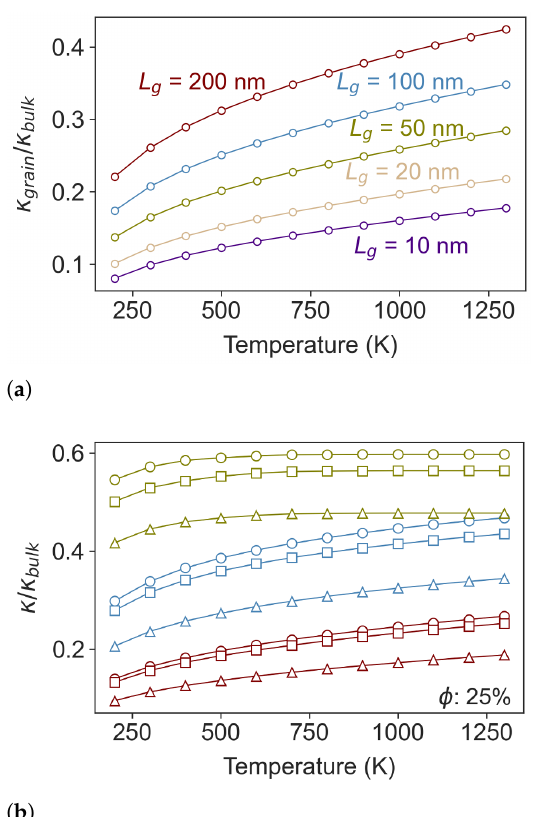
Figure 2. ( a ) Thermal conductivity of polycrystalline Si 0.8 Ge 0.2 relative to the conductivity of single- crystal material at the same temperature. The red, blue, green, gold and purple plots are for effective grains sizes of 200 nm, 100 nm, 50 nm, 20 nm and 10 nm respectively. ( b ) Reduction in thermal conductivity of single-crystal Si 0.8 Ge 0.2 alloy due to the addition of nanoscale porosity. The effects from pores with circular, square and triangular cross-section are plotted using markers of the same shape. The porosity is φ = 0.25 and the red, blue and green lines are for pore–pore distances of 0.1 µ m, 1 µ m and 20 µ m,